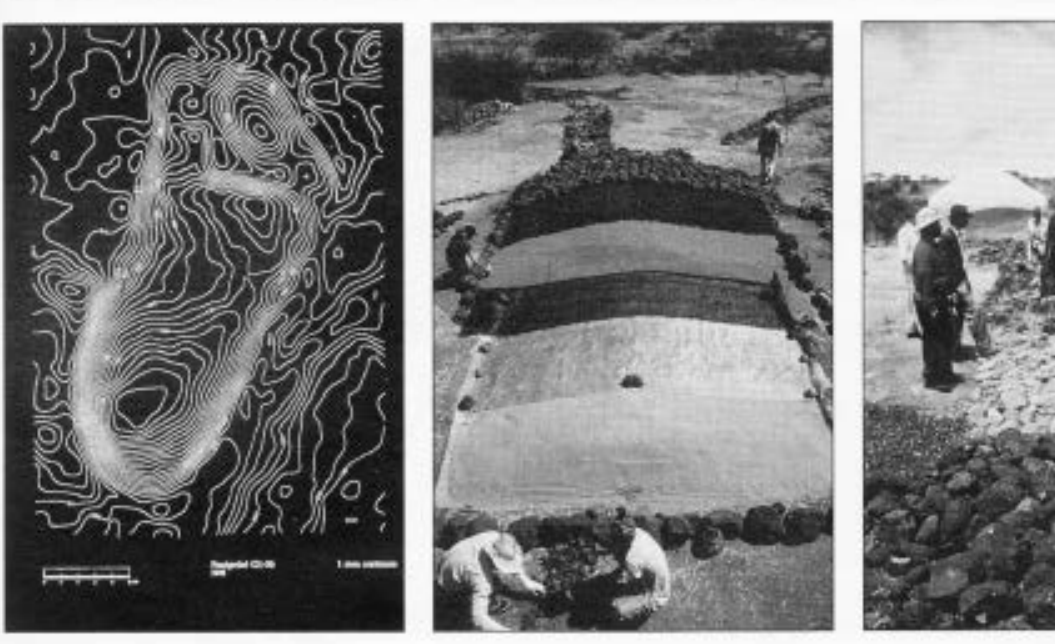
Figure 4 Laetoli: photogrammetric record of footprint G1-36 made in 1995.